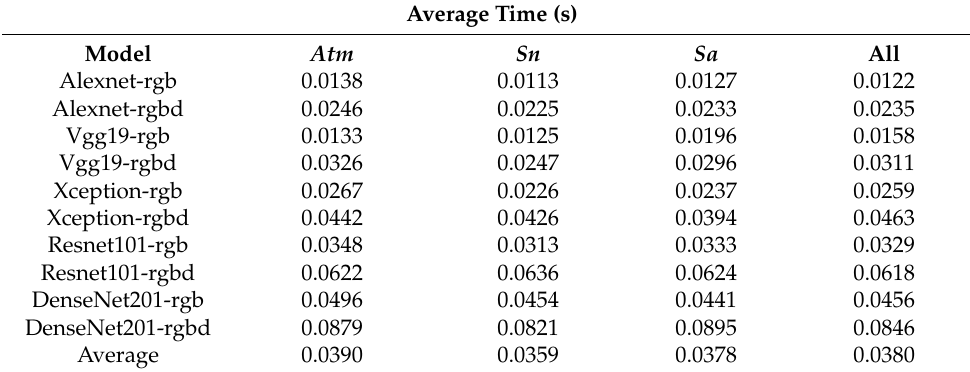
Table 4. Network average time results.